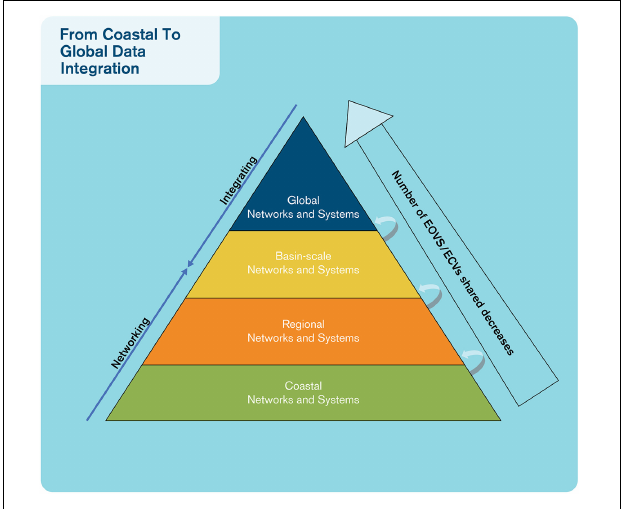
FIGURE 3 | A view of the data management systems ranging from coastal to global data